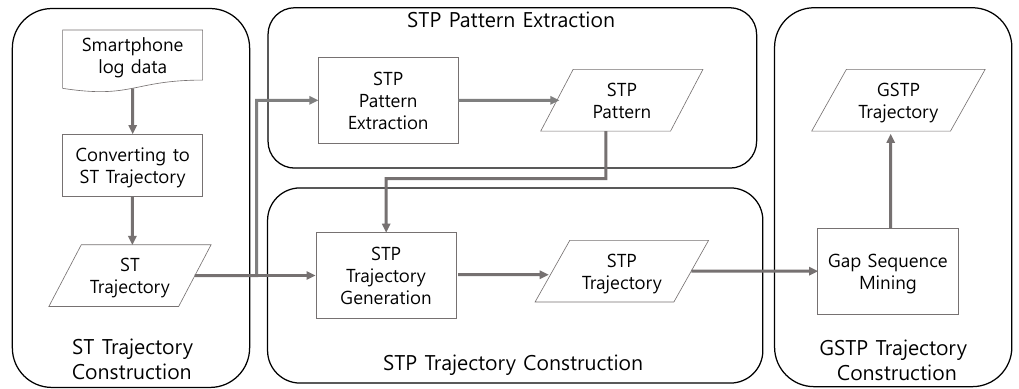
Figure 1. The training process of the proposed approach for computing gapped spatiotemporal-periodic (GSTP)